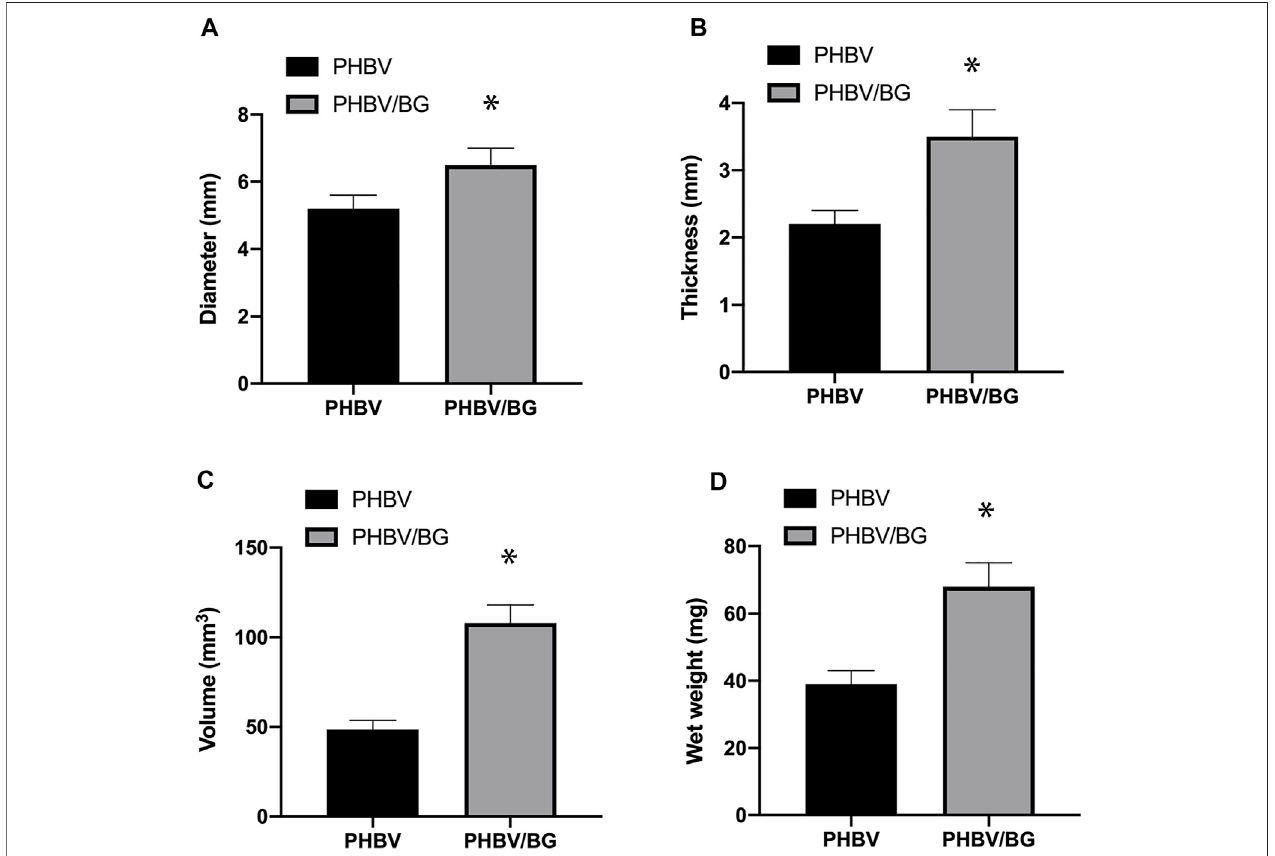
FIGURE5| Grossanalysisof invivo engineeredtissuecartilages.Thediameter (A) ,thickness (B) ,volume (C) ,andwetweight (D) oftheCPC – PHBV/10%Bioglass construct were higher than those of the CPC – PHBV construct in vivo ( p < 0.05).